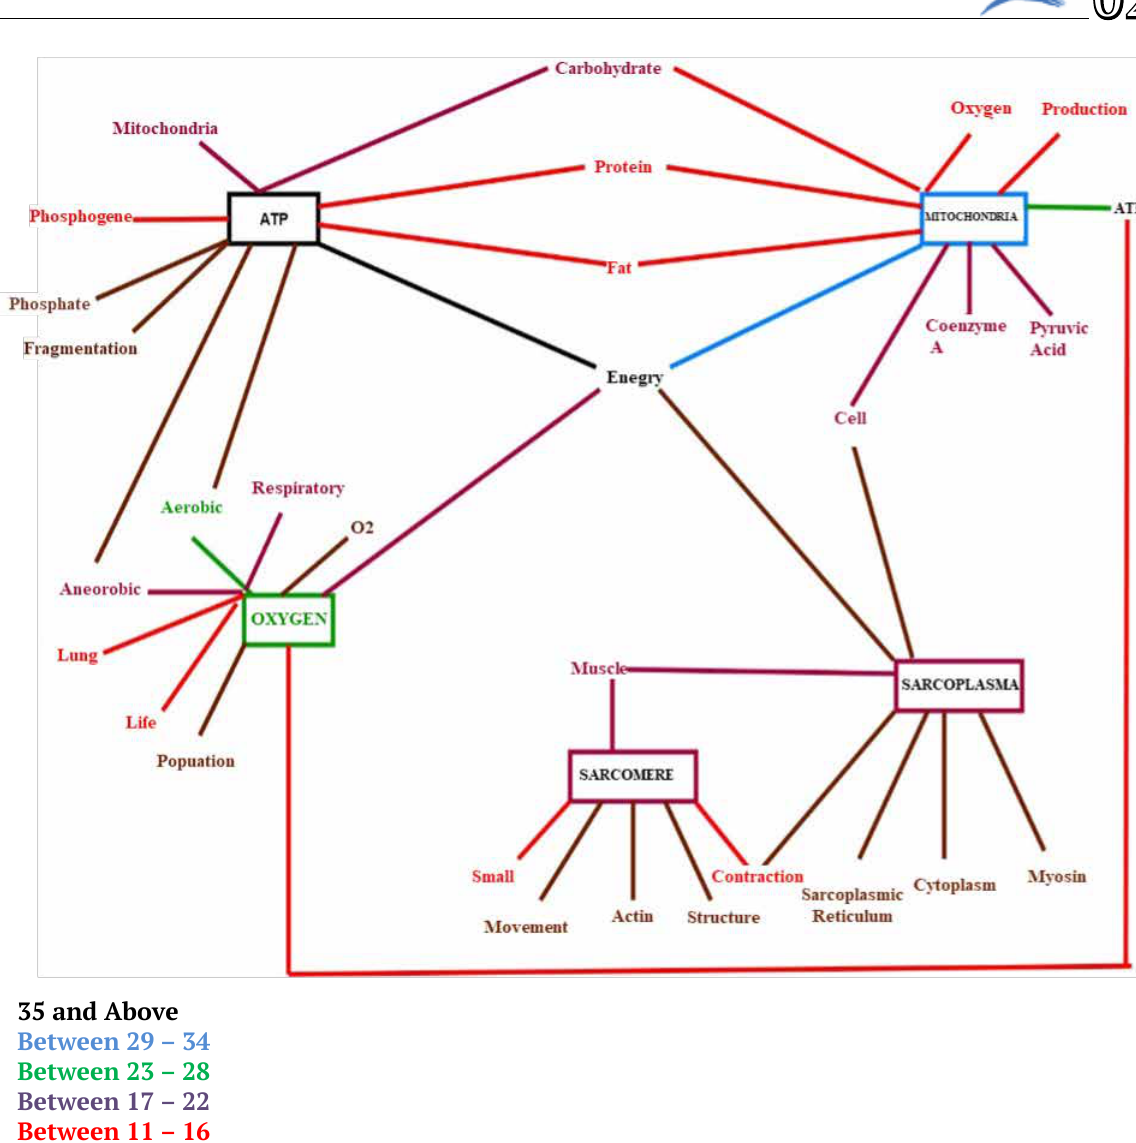
Figure 2. Concept Network Created by First Group Keywords (Pre-Test)